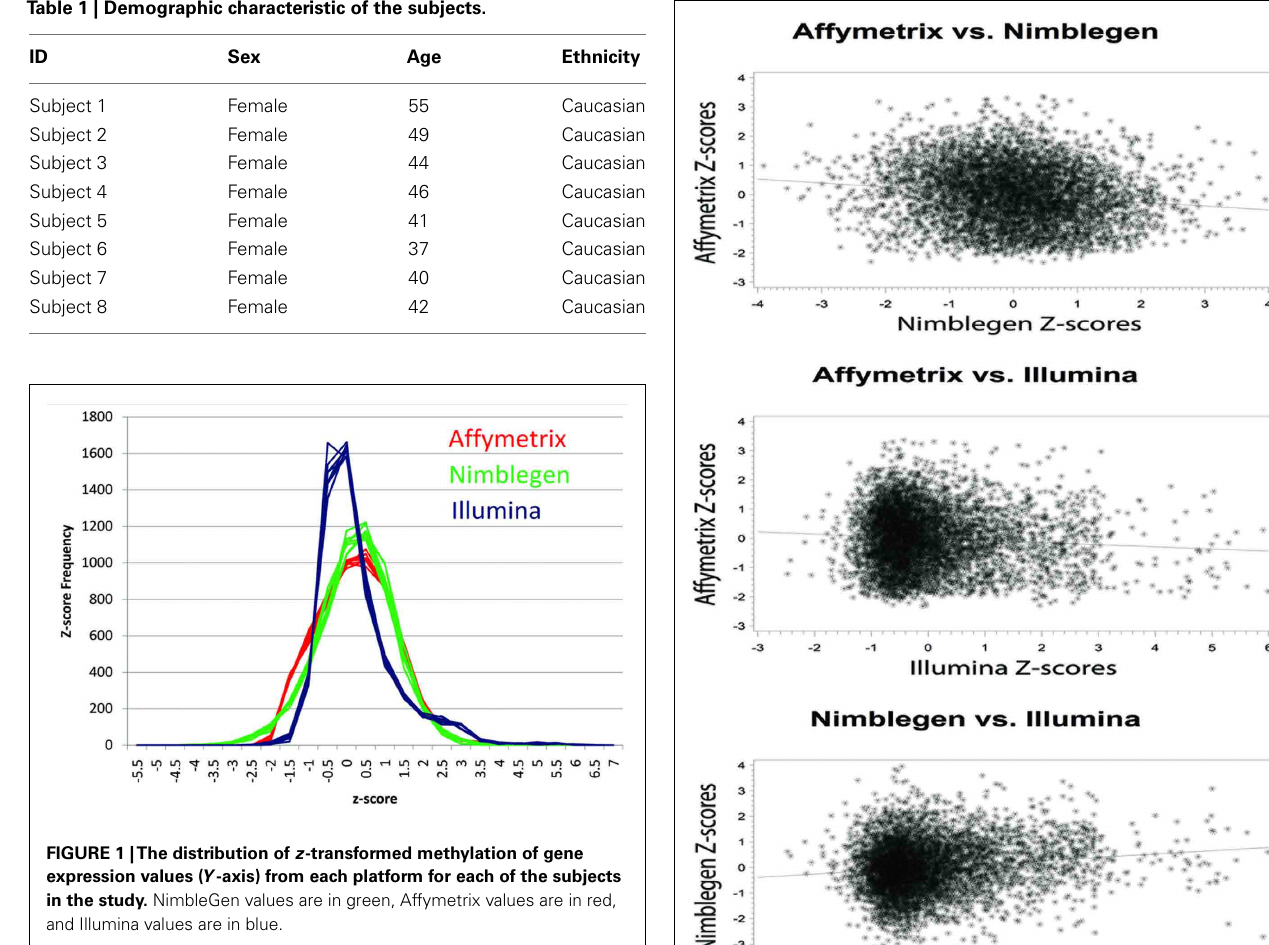
Table 1 | Demographic characteristic of the subjects.